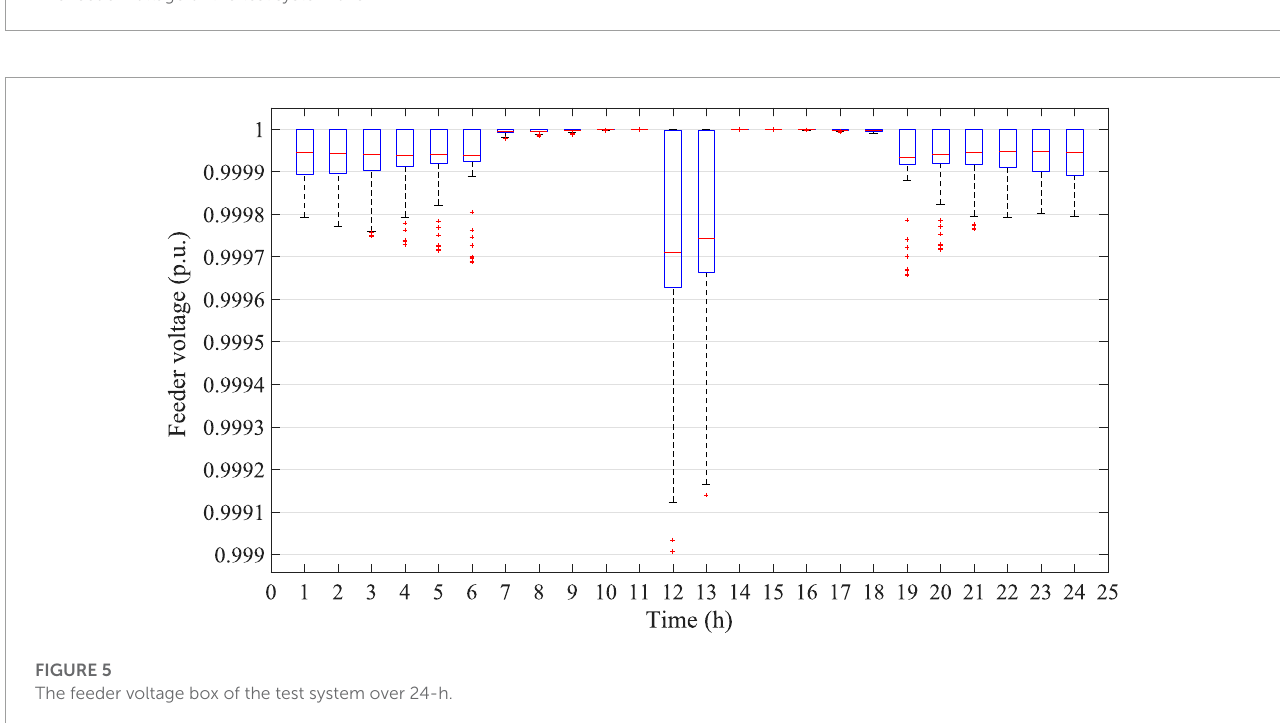
I and 0 are respectively the identity matrix and zero